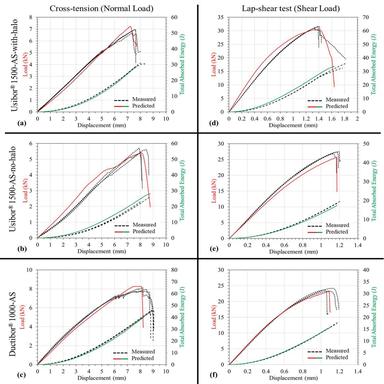
Comparison of predicted and measured load-displacement curves for different spot welds under (a), (b) and (c) under normal, and (d), (e), and (f) under shear load. The black curves are measured and three repeats are shown for each case.